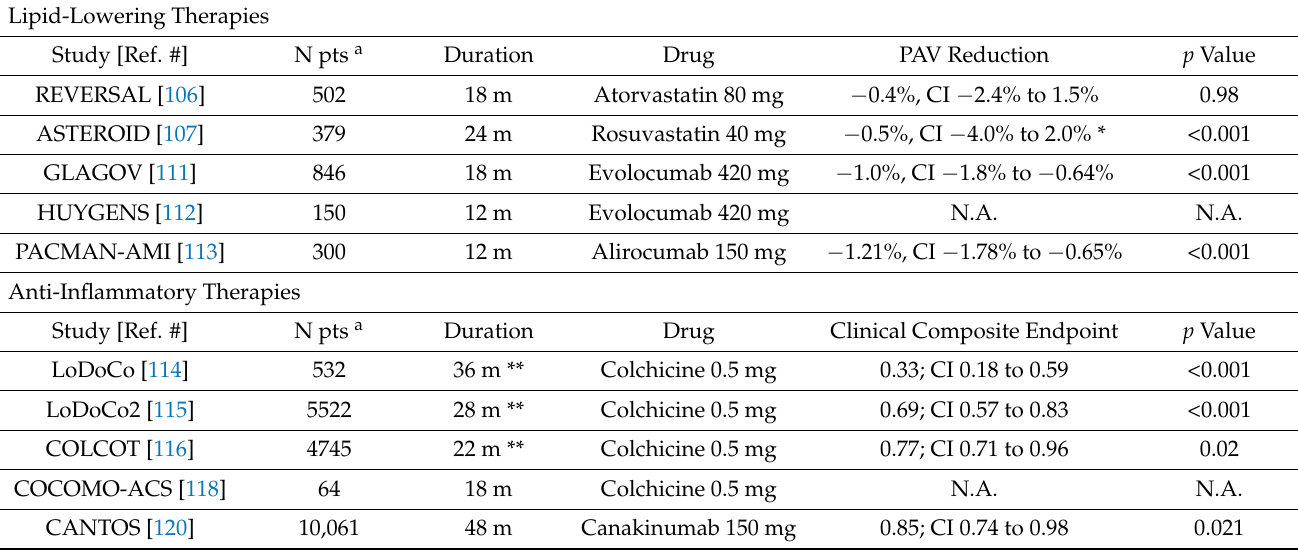
Table 2. Pharmacological studies with intracoronary imaging.